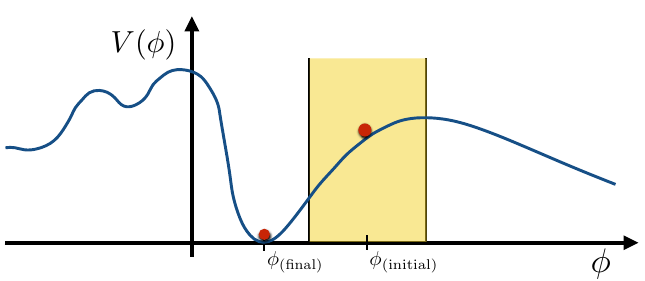
Figure 1 . Sketch of a moduli potential near its post-in(cid:13)ationary minimum (cid:30) displacement (cid:30) initial is in the yellow region the modulus is displaced in the tachyonic region of the potential and tachyonic preheating (oscillations) can take